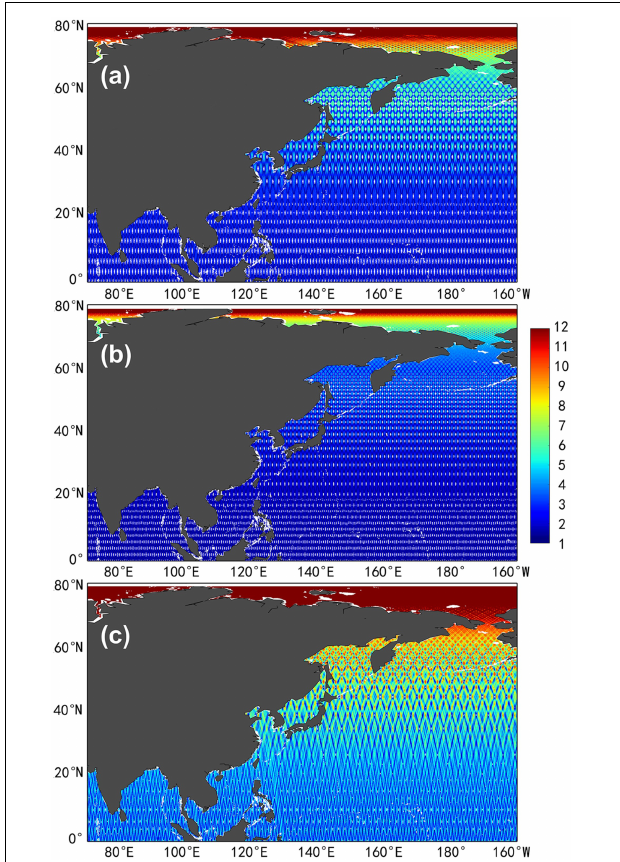
FIGURE 9 | A comparison of the sampling density (within a 1/50 ◦ × 1/50 ◦ cell) between the Guanlan and SWOT orbits. (a) Guanlan science orbit 2. (b) SWOT orbit. (c) Is a sum of (a) and (b)